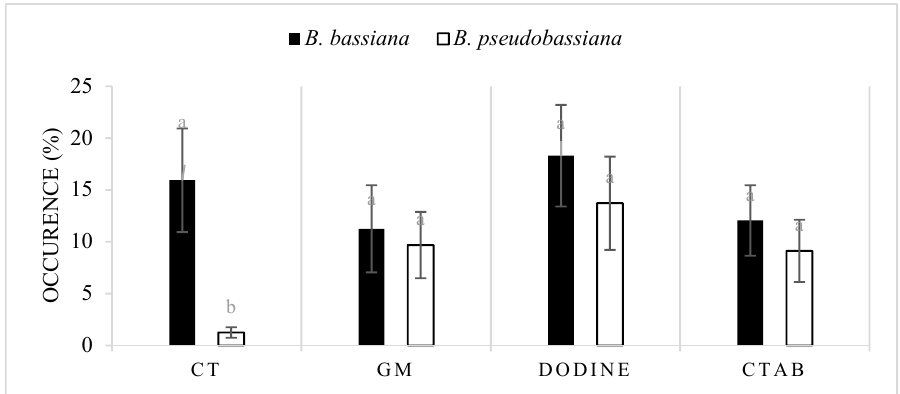
Figure 1. Occurrence rate of B. bassiana and B. pseudobassiana in the Lebanese soils using different isolation methods (CT: Cephalcia tannourinensis bait method, GM: Galleria mellonella bait method, dodine: dodine ‐ based selective medium, and CTAB: CTAB ‐ based selective medium). The values with different superscript letters in a column are significantly different ( p < 0.05).